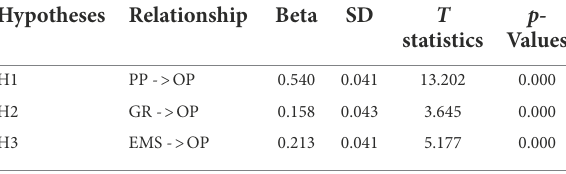
TABLE 8 R 2 Value of endogenous